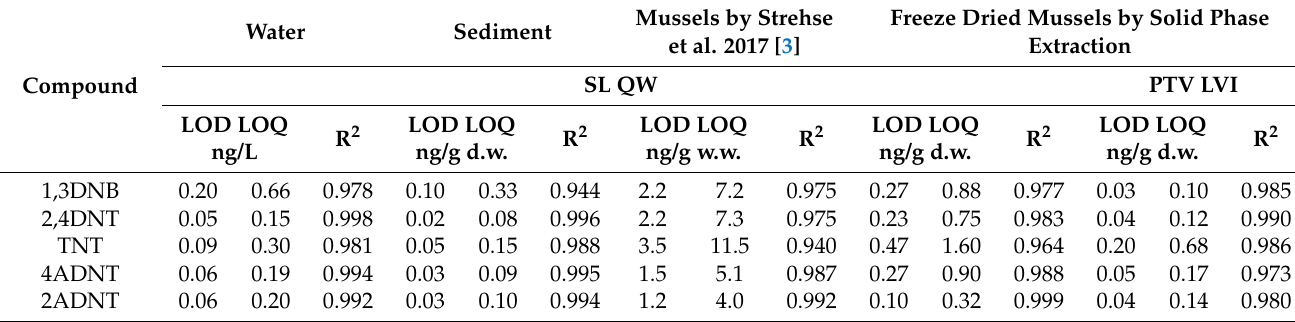
Table 4. Matrix-specific limits of detection of the methods developed for water, sediment, and mussel samples. Mussels by Strehse Freeze Dried Mussels by Solid Phase Water Sediment et al. 2017 [3] Extraction SL QW PTV Compound